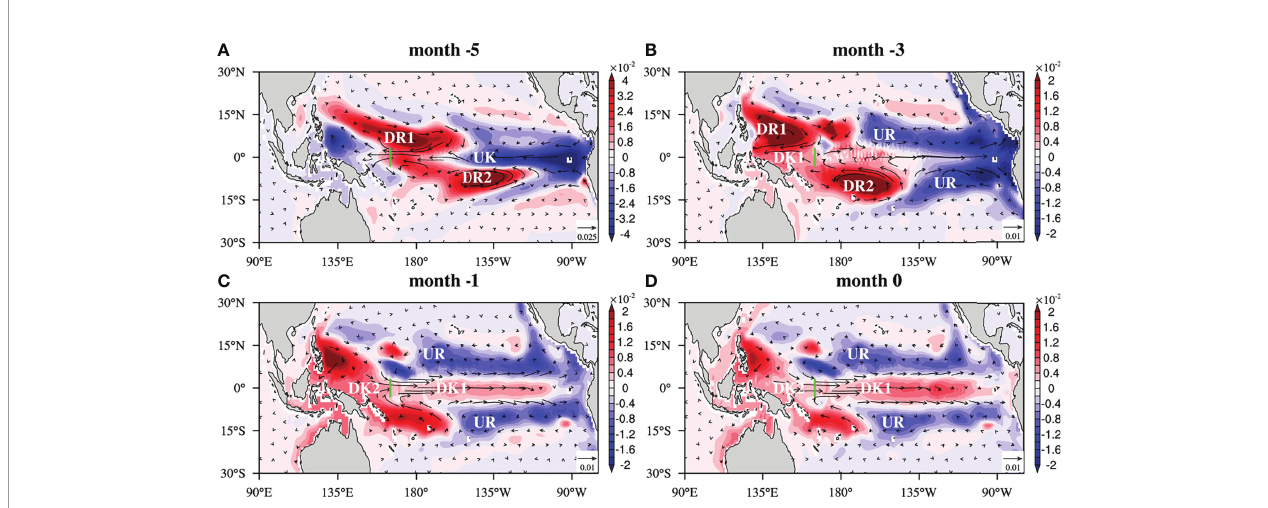
FIGURE 11 | Time evolutions of both the SSH anomalies (color shading; m) and zonal velocity anomalies averaged between s q = 23.0 and 26.2 (vectors: m s – 1 ) at (A) 5 month, (B) 3 month, (C) 1 month previously, and (D) the target month in response to the sensitivity-like wind velocity perturbations at month – 6. UK, DK, UR, and DR denote an upwelling Kelvin wave, a downwelling Kelvin wave, an upwelling Rossby wave, and a downwelling Rossby wave, respectively. Note that the representative values of the color bars and reference vectors gradually decrease with different months. And the target section is marked as the green